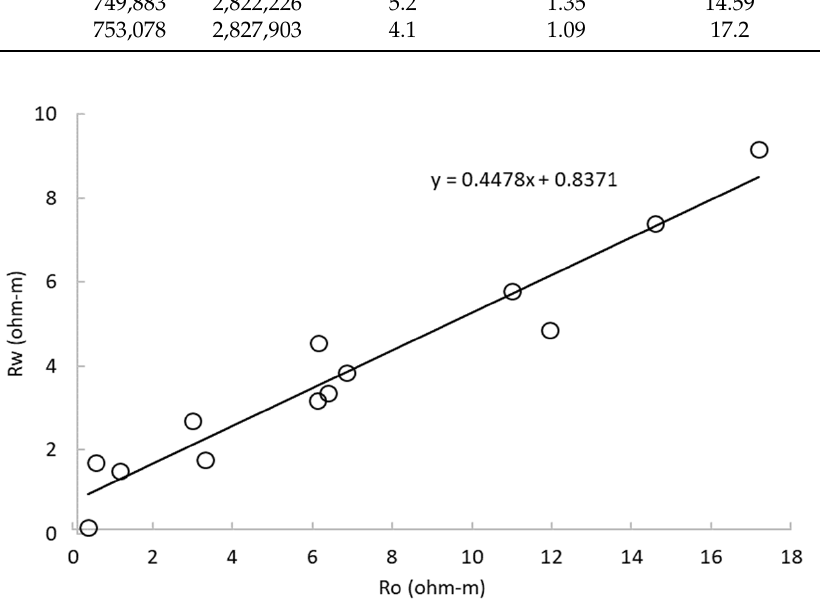
Figure 4. Linear regression of resistivity of the saturated formation Ro and electrical resistivity of the aquifer water Rw obtained from 13 wells in the communities of the study area.